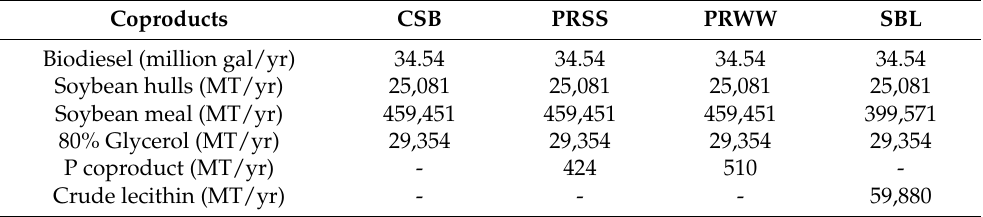
Table 1. Main product and coproduct production in the four cases of soybean processing.